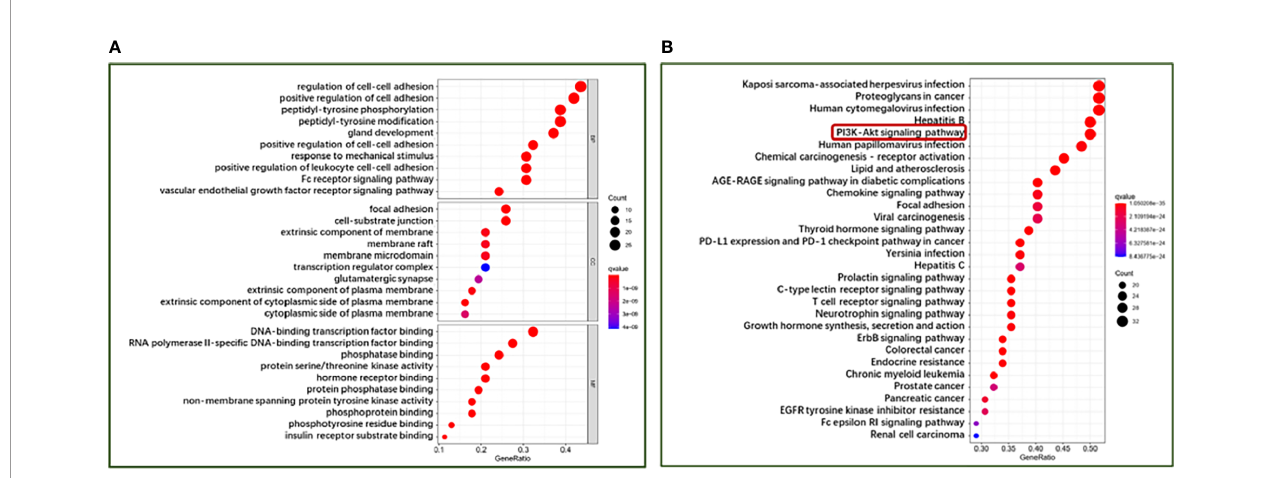
FIGURE 5 | The bubble diagram of (A) GO function enrichment and (B) KEGG pathway enrichment analysis of 62 hub targets from the HMMCR for treatment of NSCLC. The larger the number of enriched targets, the bigger the dots; the smaller the p-value, the redder the color of the dot.